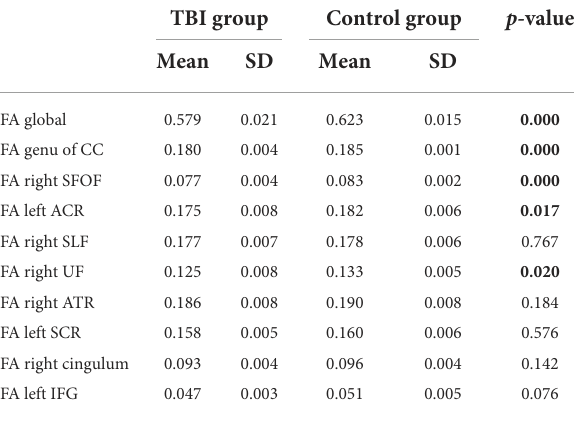
TABLE 5 Group differences in mean FA from the whole skeletonised brain and the ROIs.